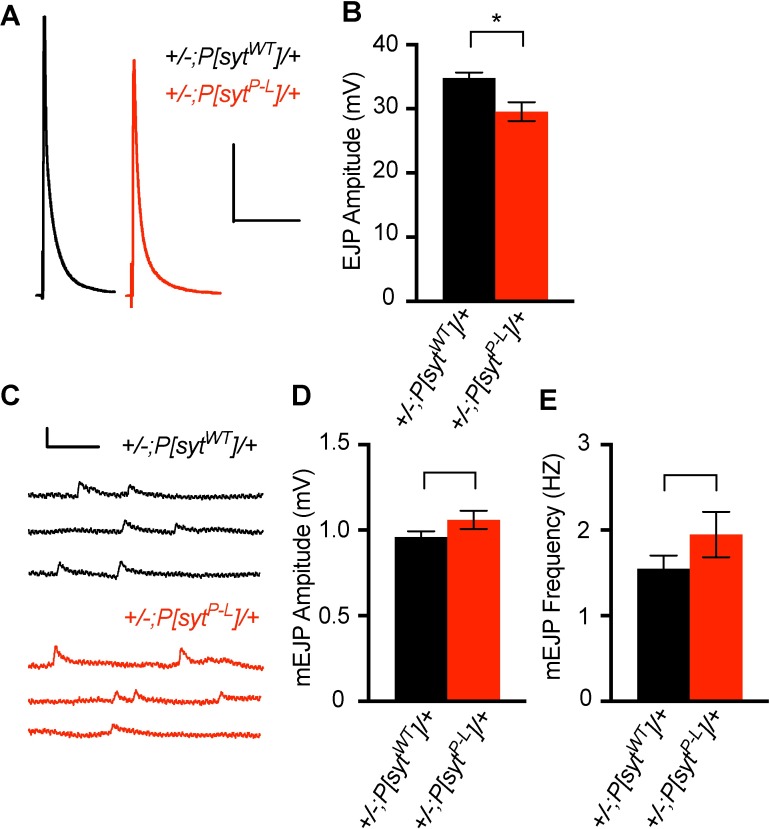
Synchronous evoked release is impaired in P[sytP-L] heterozygotes, but quantal content is unchanged.(A) Representative EJP traces for control and P[sytP-L] heterozygotes. Scale bars represent 10 mV, 0.2 s. (B) Mean EJP amplitude is significantly less in P[sytP-L] heterozygotes (n = 19) compared to control (n = 12, *p = 0.002). Error bars depict SEM. (C) Representative consecutive 3 second mEJP traces for control and P[sytP-L] heterozygotes. Scale bars represent 1 mV, 0.2 s. (D, E) Neither mean mEJP amplitude (p = 0.09, Wilcoxon Rank-Sum Test, D) nor mean mEJP frequency (p = 0.18, student t-test, E) is significantly different between P[sytP-L] heterozygotes (n = 12 fibers) and control (n = 19 fibers). Error bars depict SEM.